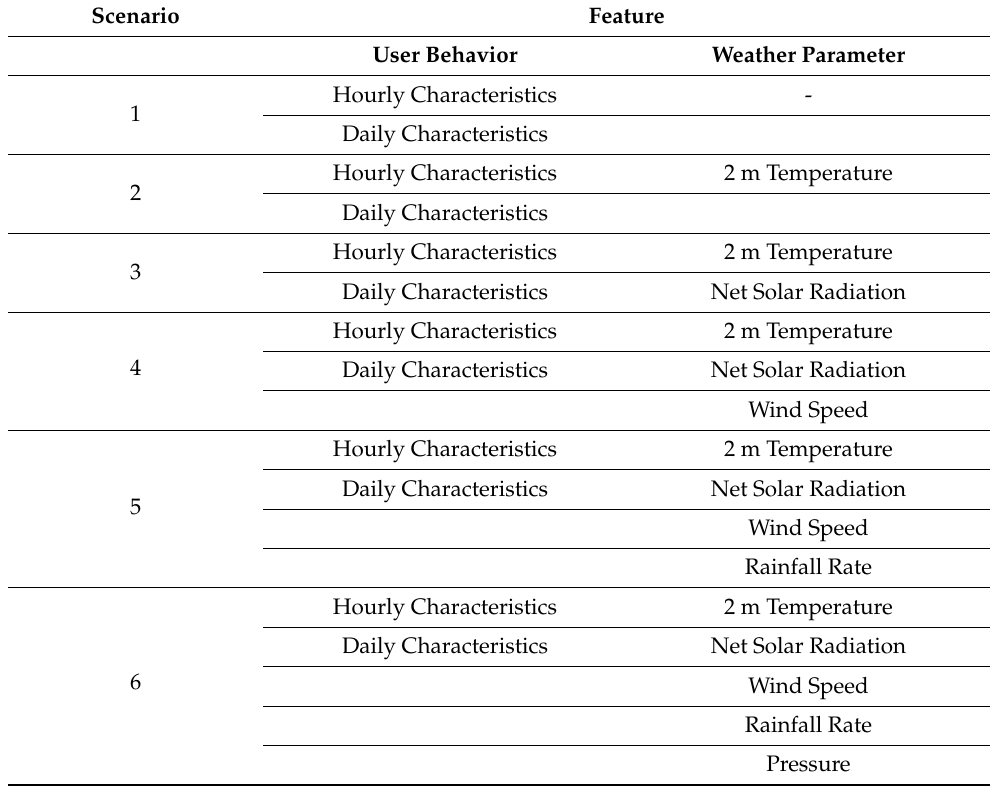
Table 2. Scenarios to investigate effects of each weather parameter as feature input for the machine